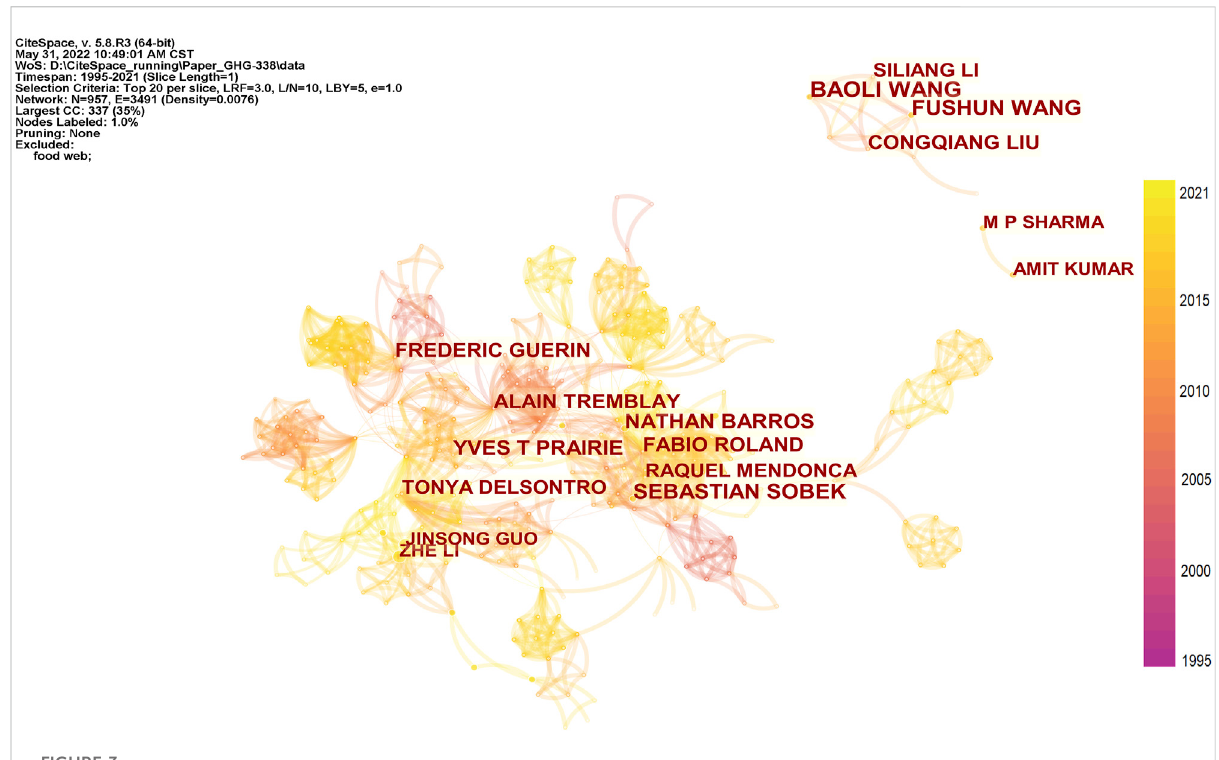
FIGURE 3 Author collaboration